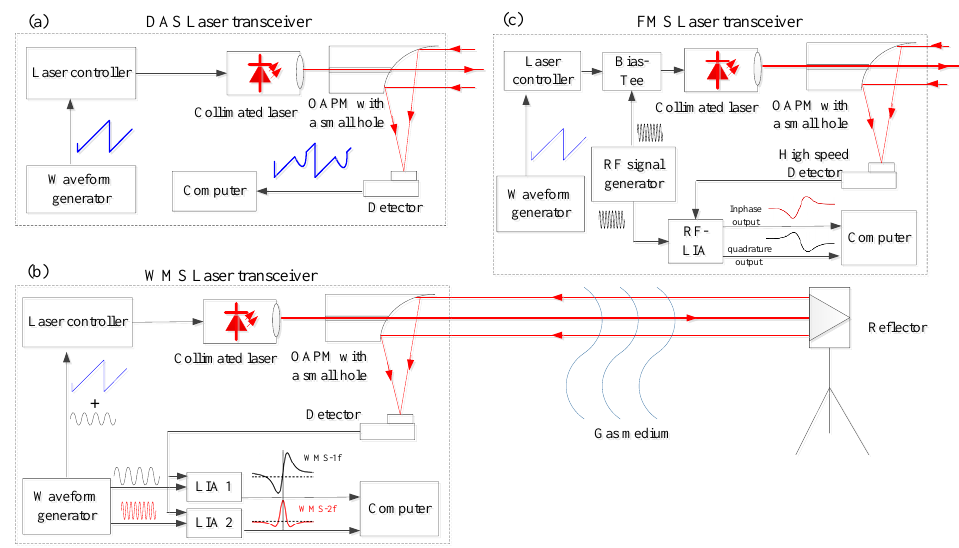
Figure 2. Three schemes of tunable diode laser absorption spectroscopy (TDLAS) systems for open-path standoff detection with an optical reflector with direct absorption spectroscopy (DAS) ( a ) wavelength modulation spectroscopy (WMS) ( b ) and frequency modulation spectroscopy (FMS) ( c ) RF, radio frequency, LIA, lock-in amplifier, OAPM, off-axis parabolic mirror.